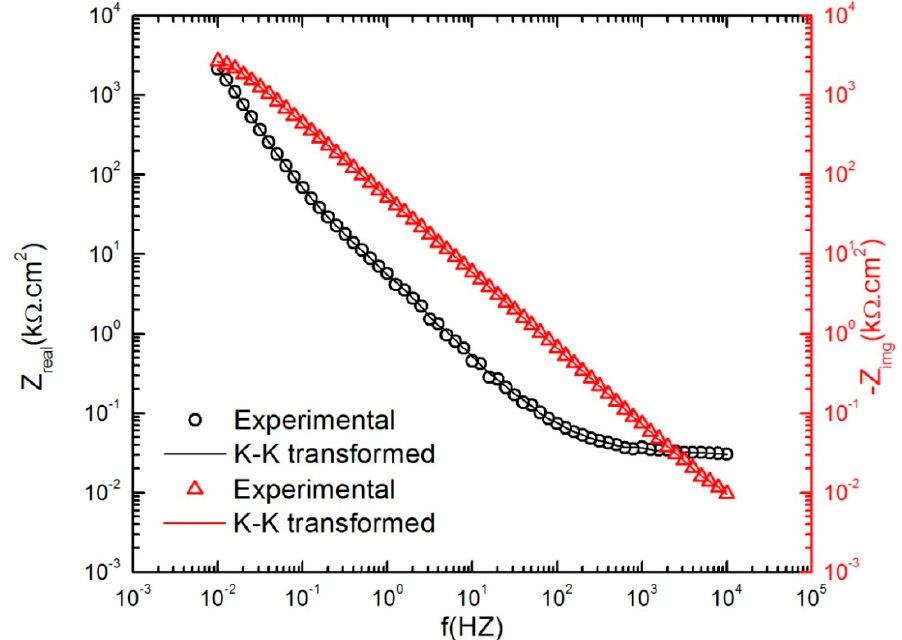
Figure 6. Agreement of the experimental and Kramers–Kronig transforms of the real and imaginary component of the impedance data of the AA2098–T851 alloy after 24 h of polarization at 300mV SCE in contact with 1 atm CO 2 (pH = 6.7, 25 °C) during the anodic potential stepping.